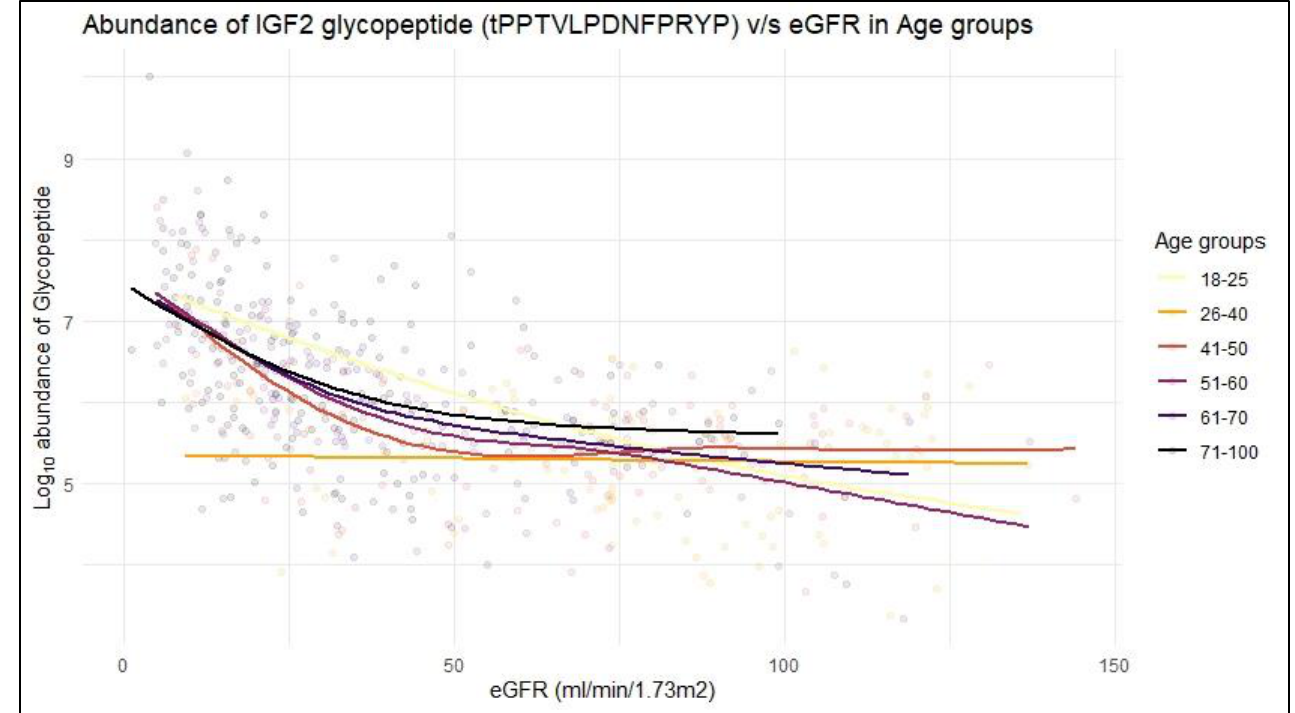
Figure 5. Correlation of the urinary IGF2 glycopeptide “tPPTVLPDNFPRYP” intensity with clinical parameter eGFR (mL/min/1.73 m 2 ) for different age groups. Data were fit using a generalized additive model (GAM) suggesting significant correlations ( p < 0.05) for all but one (age 61 – 70) age group.